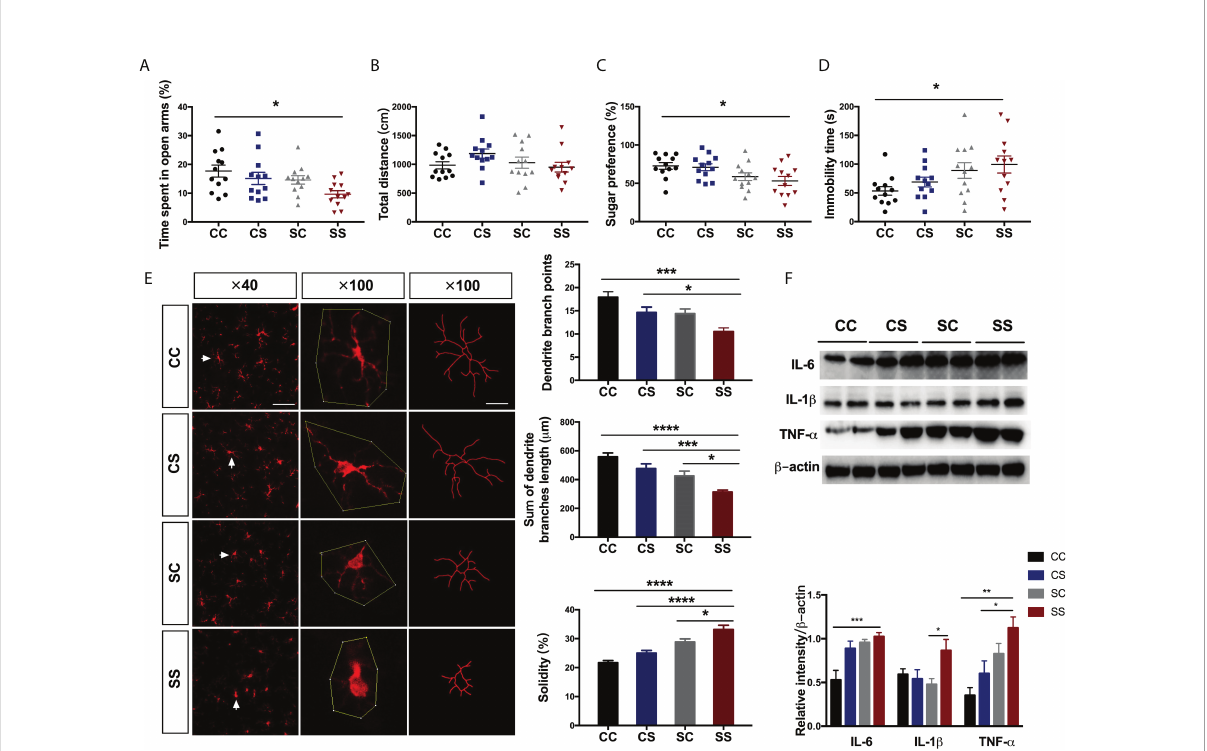
FIGURE 2 Anesthesia/surgery aggravated behavioral de fi cits and neuroin fl ammation in rats with preoperative stress (A, B) Time spent in the open arm (A) (n = 2/group) and total travel distance (B) (n = 12) in the four groups. (C, D) Sugar preference in SPT (C) (n = 12/group) and immobility time in FST (D) (n = 12/group) in the four groups. (E) Immuno fl uorescence staining and morphological analysis of microglia in the hippocampus (n = 16/group). Arrows denote the area represented in the inset. Scale bar = 50 µm; 20 µm for the inset. (F) Representative blot and quantitative analysis of IL-6, IL-1 b , and TNF- a in the hippocampus (n = 6/group). One-way ANOVA and Tukey ’ s multiple comparisons test were used to analyze the data. Data represent mean ± SEM. * P< 0.05, ** P< 0.01, *** P< 0.001, **** P< 0.0001 vs SS group. CC, no stress; SC, only preoperative stress; CS, only anesthesia/surgery stress; SS, preoperative stress and anesthesia/surgery